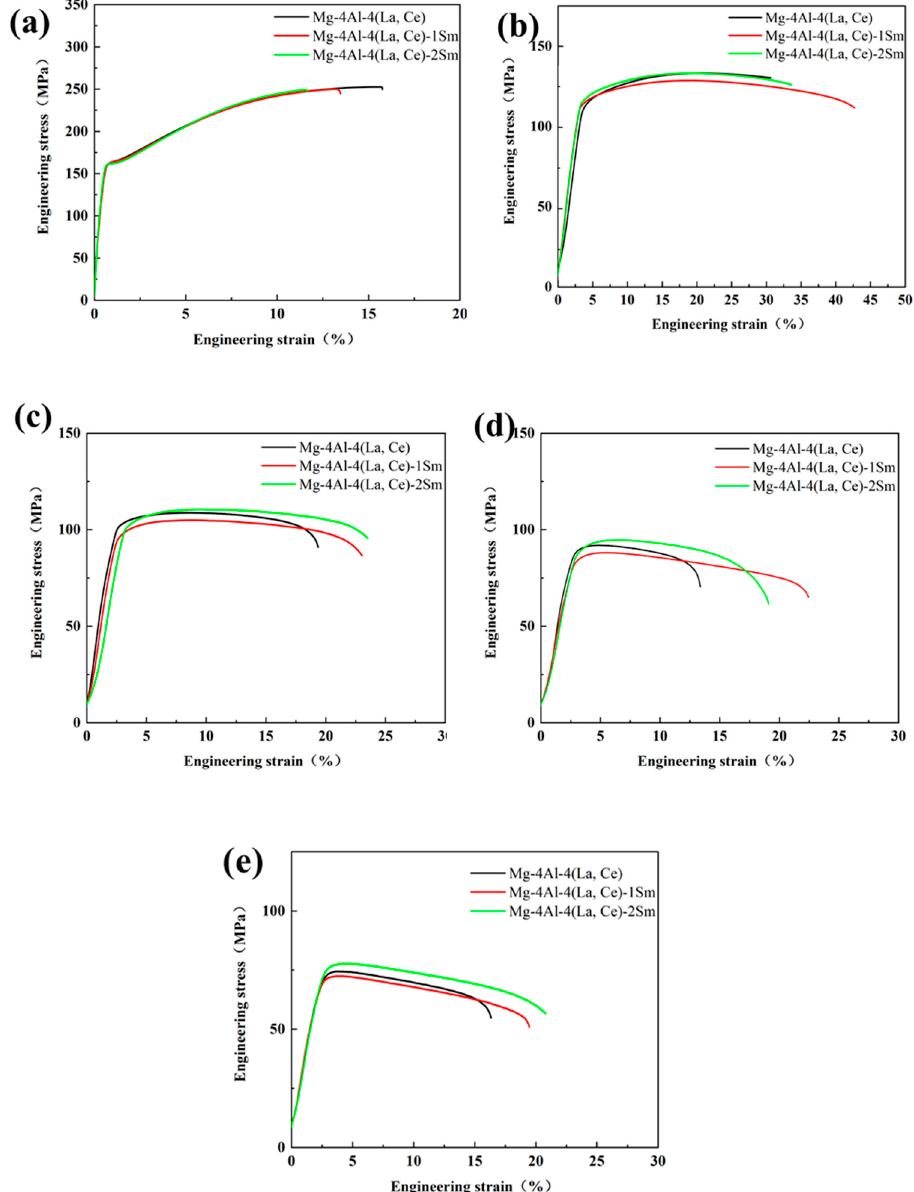
Figure 8. Representative tensile curve of Mg-4Al-4 (La, Ce) alloy after adding different contents of Sm ( a ) RT; ( b ) 150 °C; ( c ) 200 °C; ( d ) 250 °C; ( e ) 300 °C.